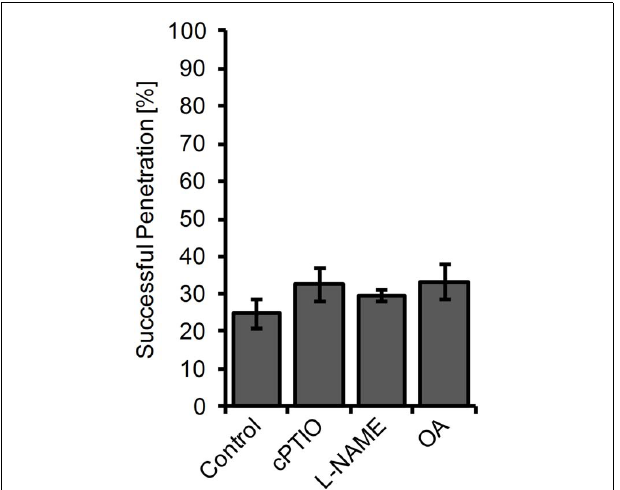
FIGURE 6 | Penetration rate of Erysiphe pisi on Arabidopsis is not affected by inhibitors of NO formation. Arabidopsis wild type plants were treated for 2 h with 200 μ M cPTIO, 100 μ M L-NAME, 100 μ M OA, or DMSO (control) in 10 mM MgCl 2 before inoculation with the powdery mildew fungus E. pisi and host cell penetration was quantified 48 h post-inoculation. Data represent the mean ( ± SD) of all (at least 100) interactions sites analyzed on six leaves taken from two different plants.